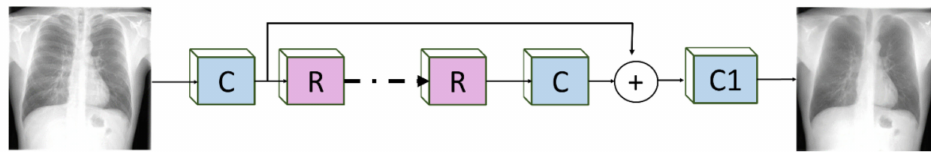
Figure 4. The architecture of the proposed ResNet–BS model. The convolutional block is denoted by C, having 64 filters of size 3 × 3 and zero paddings to preserve input dimensions. R denotes the modified ResNet block where the final ReLU activation is removed together with the batch normalization layer. The proposed model has 16 ResNet blocks. The deepest convolutional layer C1 with a single filter, zero paddings, and sigmoidal activation, predicts the bone-suppressed